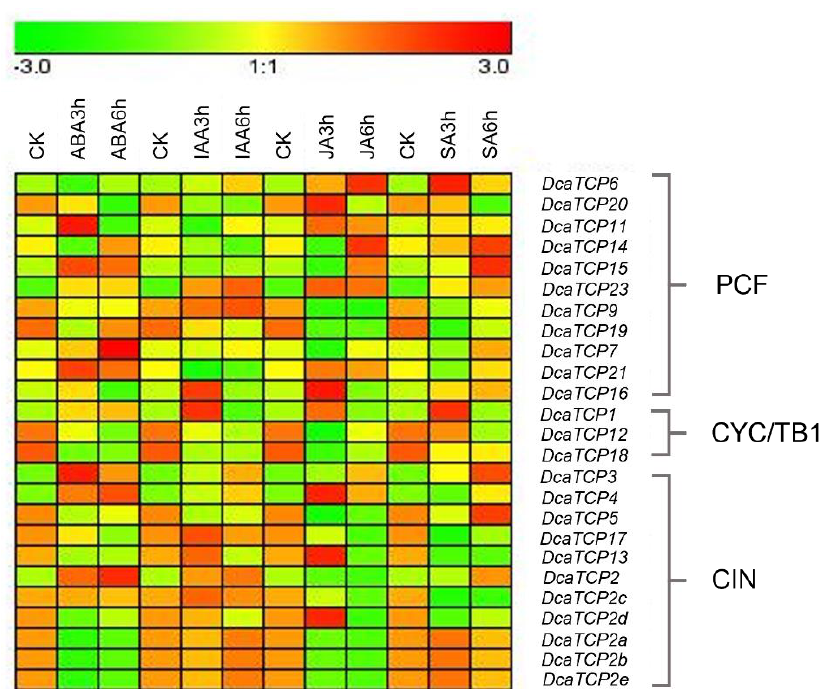
Figure 6. Expression analysis of DcaTCP genes after treatment with ABA, IAA, JA and SA. ABA: abscisic acid, IAA: indole-3-acetic acid, JA: jasmonic acid, SA: salicylic acid. ck: control check, 3 h: phytohormone treatments after 3 h, 6 h: phytohormone treatments after 6 h.